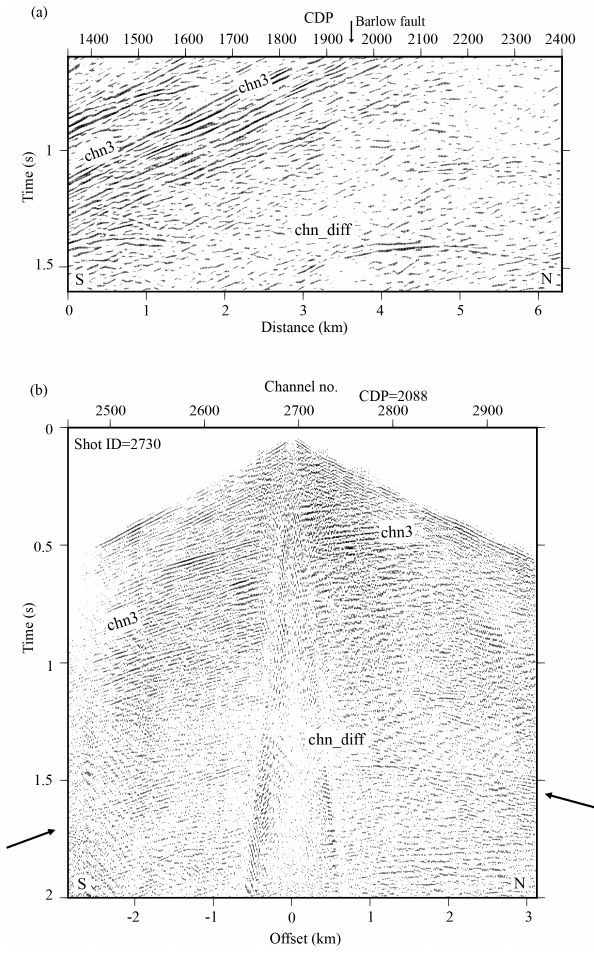
Figure 11. (a) A zoomed view from Fig. 8b (DMO stacked section with cross-dip element 12 ◦ to the west applied) around the diffrac- tion chn_diff. (b) Shot 2730 (see Fig. 4 for the location) acquired for the north survey, which shows the signal from the diffraction chn_diff; the apex of chn_diff is imaged around CDP 2088 in (a) . The location of CDP 2088 is shown in (b) . See text for interpreta-